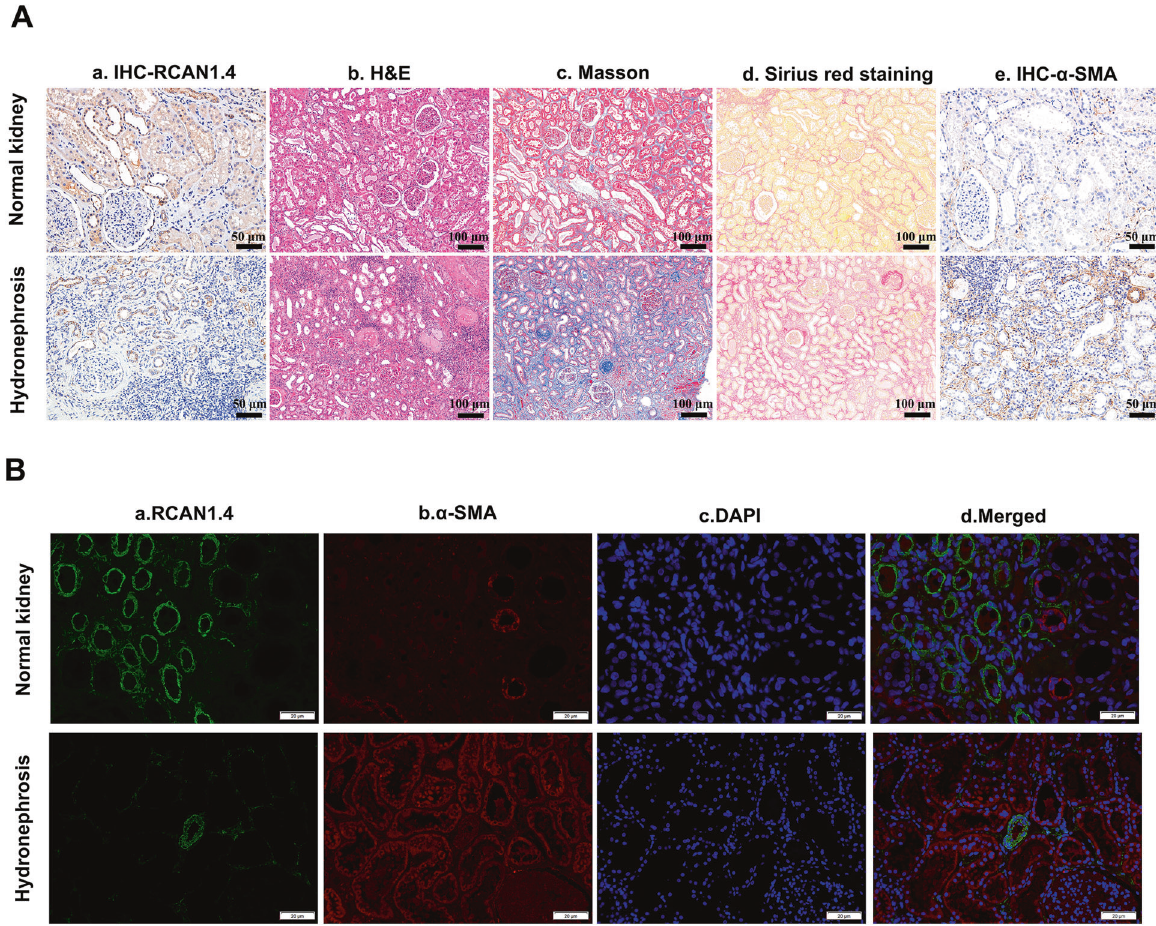
Fig. 8 RCAN1.4 expression correlated with renal interstitial fi brosis in human kidney biopsy specimens. A a , e Immunohistochemistry signals of RCAN1 and α -SMA (Scale bars, 50 μ m); A b , c , d H&E, Masson, Sirius red of kidney interstitium tissue (Scale bars, 100 μ m). B RCAN1 and α -SMA protein expression in renal tissue was examinated by immuno fl uorescence (Scale bars, 20 μ m). The results are expressed as the mean ± standard error of the mean